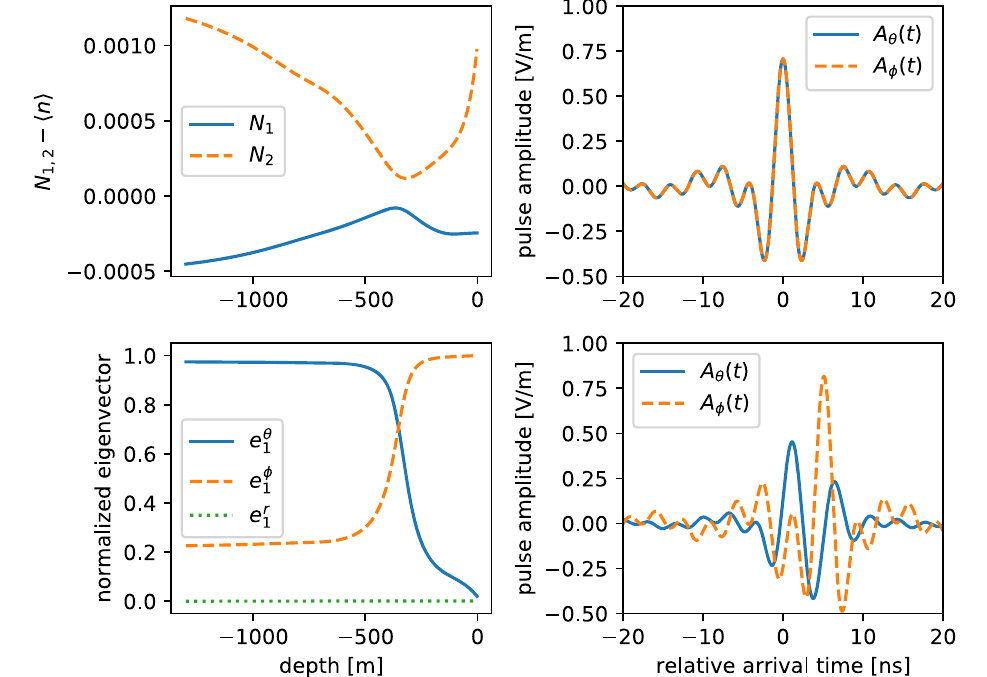
Fig. 4 Displayofthepulsepropagationpropertieswithvertexposition at [0m, 0m, − 1300m] and antenna position at [1500m, 200m, − 1m]. Top left: Effective refractive indices N 1 , 2 against depth. The density effect is subtracted to be able to see the relative behaviour. Bottom left: